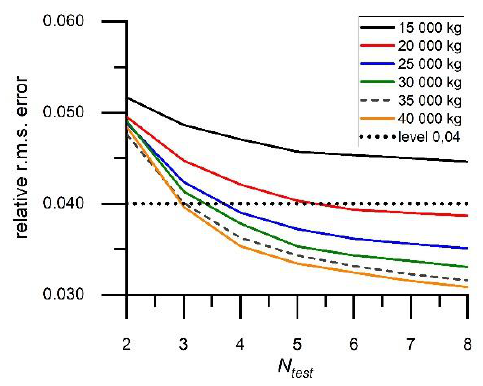
Figure 5. Influence of the weight distribution of test vehicles in the measurement range of the WIM system on the bias error of vehicle weighing results for various algorithms for estimating calibration coefficients ( 𝐶 𝑟𝑒𝑓 = 1 , 𝑏 𝑟𝑒𝑓 = 0.1𝑍 𝑚𝑖𝑛 ),